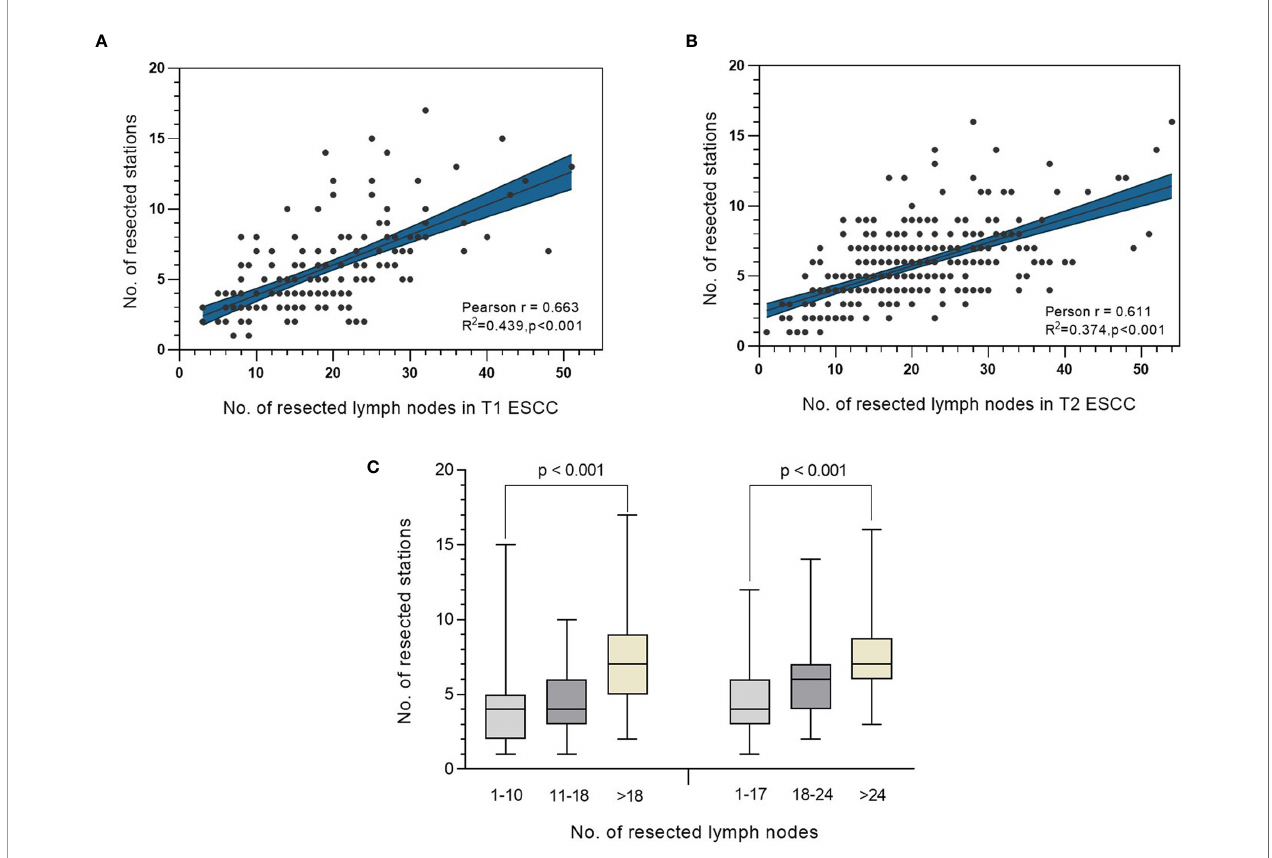
FIGURE 3 | (A, B) Correlation analysis between number of resected lymph nodes and the corresponding lymph node stations in T1 and T2 ESCC. (C) Distribution of number of resected stations in different categories of resected lymph nodes in patients with T1 ESCC (left panel) or T2 ESCC (right